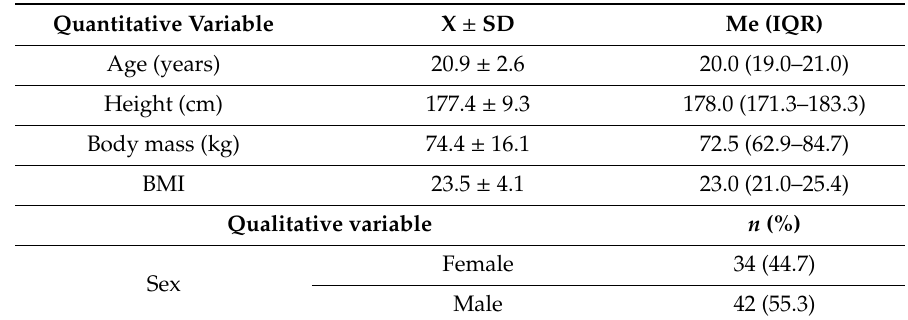
Table 1. Anthropometric variables, physical activity patterns and allergy status of the study group ( n =